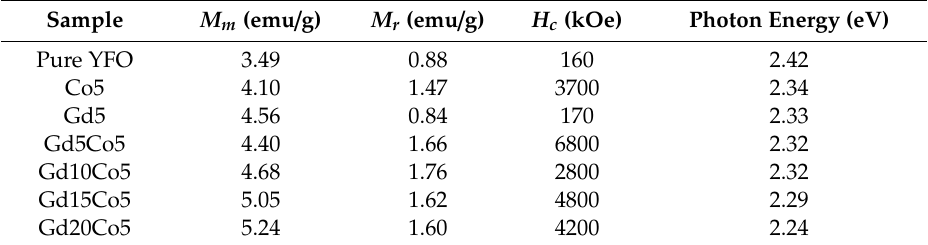
Figure 4. Magnetic hysteresis loops of as-prepared nanoparticles: ( a ) YFO; ( b ) Co5; ( c ) Gd5; ( d ) Gd5Co5; ( e ) Gd10Co5; ( f ) Gd15Co5; ( g ) Gd20Co5. Table 2. List of the magnetic and optical parameters for YFeO 3 powders.